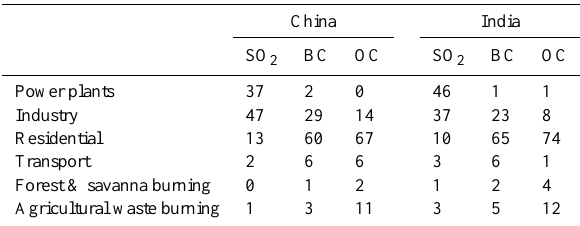
Table 3. Average contribution of each sector to total uncertainties during 1996–2010 (unit: